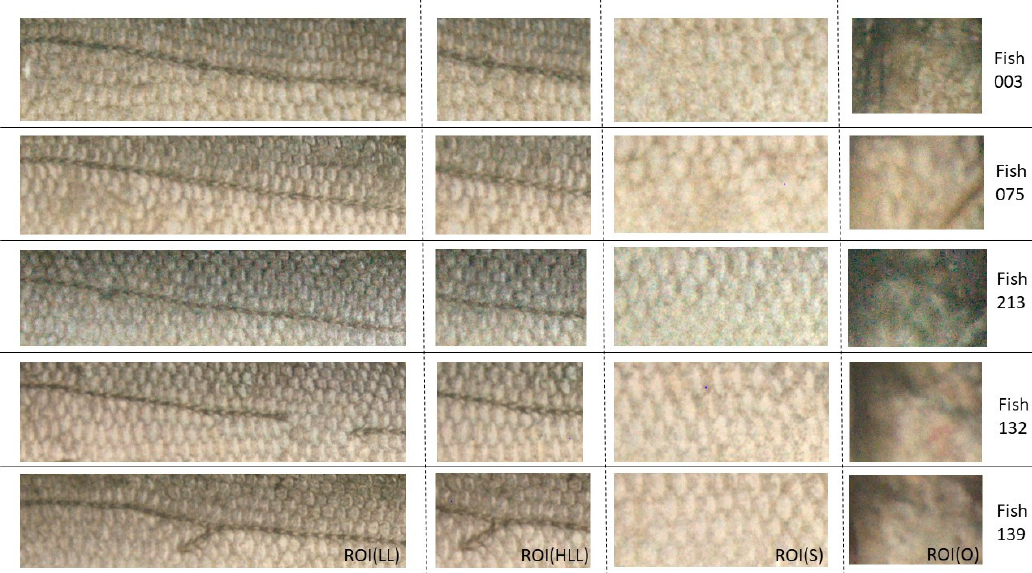
Figure 8. Differences in ROIs for different fish (seabass). The best results were obtained using ROI(LL), where the region of the fish body covered the lateral line and offered high classification power. ROI (HLL) also had high accuracy (98.66%). This region covered the middle part (1/3) of the lateral line of ROI (LL). The accuracy, however, decreased for both the short- and long-term experiments. The most probable reason for this decrease is a lack of detail. The lateral line’s unique